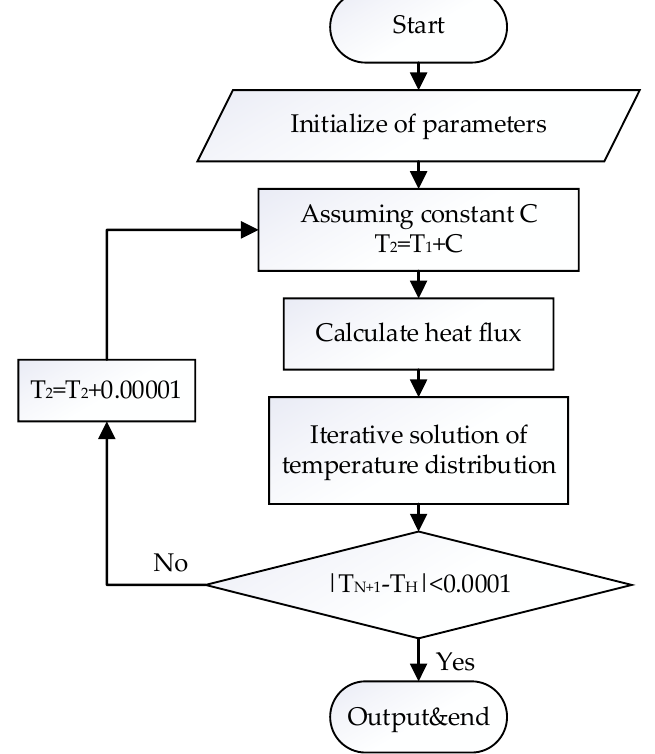
Figure 1. Flow chart of the layer-by-layer calculation model.